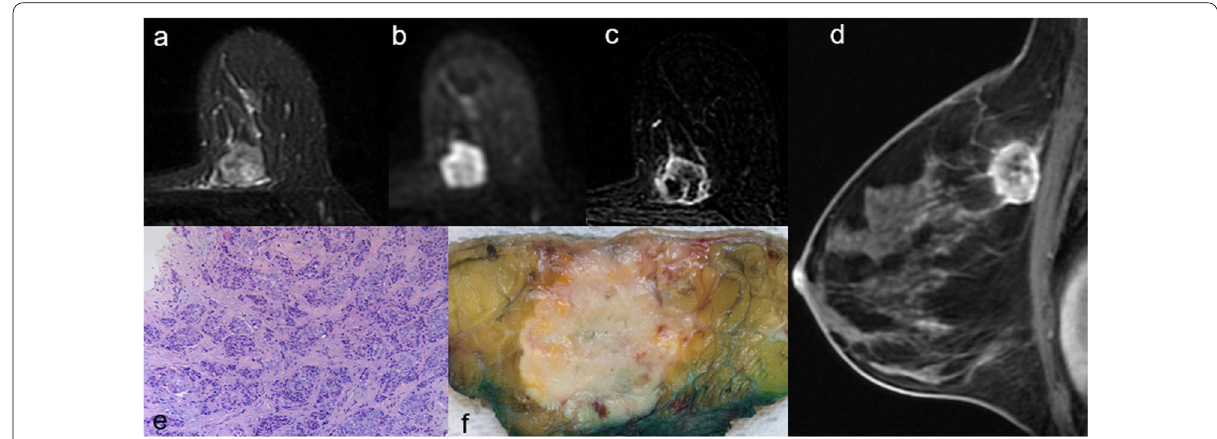
Fig. 4 A 45-year-old woman with triple-negative tumour of the left breast. a Axial fat-suppressed T2-weighted image shows an 18-mm, heterogeneously hyperintense round mass with non-circumscribed margins in the upper inner quadrant of the left breast. b Axial diffusion-weighted imaging ( b -value 1,000 s/mm. 2 ) shows peripheral high signal intensity and central hypointensity. c Axial and ( d ) sagittal = post-contrast T1-weighted subtracted images show a corresponding irregular round mass with rim enhancement. e On cut surface, the lesion is round shaped with smooth margins. f Histologic examination confirms the diagnosis of infiltrating carcinoma of “no special